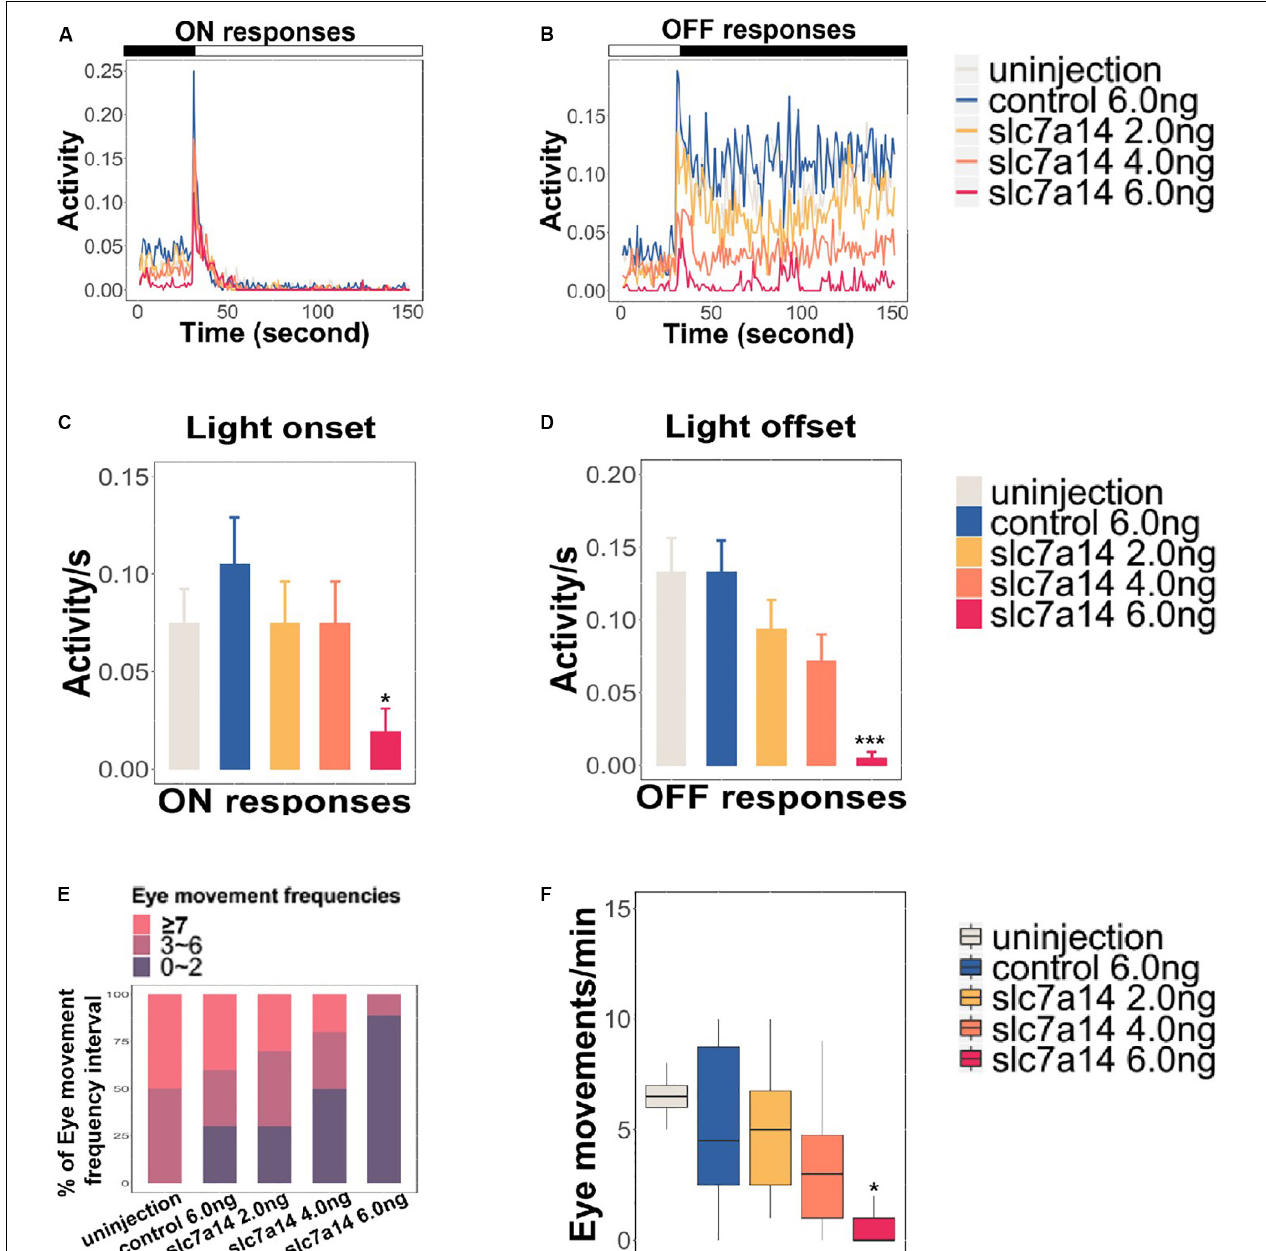
FIGURE 5 | Slc7a14 -deficient zebrafish morphants showed defective visual behaviors. (A,B) VMR testing in slc7a14 -deficient zebrafish morphants. Larvae injected with slc7a14 -MO (6.0 ng) showed a weaker ON response and a significantly attenuated OFF response compared to control larvae. N = 12 in each group. (C,D) Quantification of the VMR. N = 12 in each group. (C) Larvae injected with slc7a14 MO (6.0 ng) showed a reduced ON response compared with control larvae. (D) Compared with control larvae, larvae injected with 4.0 ng MO and 6.0 ng slc7a14 -MOs exhibited markedly reduced OFF responses. (E,F) OKR testing demonstrated significant reductions in eye movement in the slc7a14 -deficient zebrafish morphants compared to the control zebrafish. N = 10 in each group. VMR testing and OKR testing were repeated three times, respectively. Data was analyzed using One-way ANOVA followed by Games–Howell test, ∗ P ≤ 0.05, ∗∗∗ P < 0.001 significantly different from control 6.0 ng